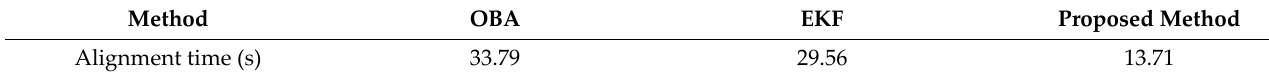
Table 3. Alignment time of three different IFA methods in the experiment.